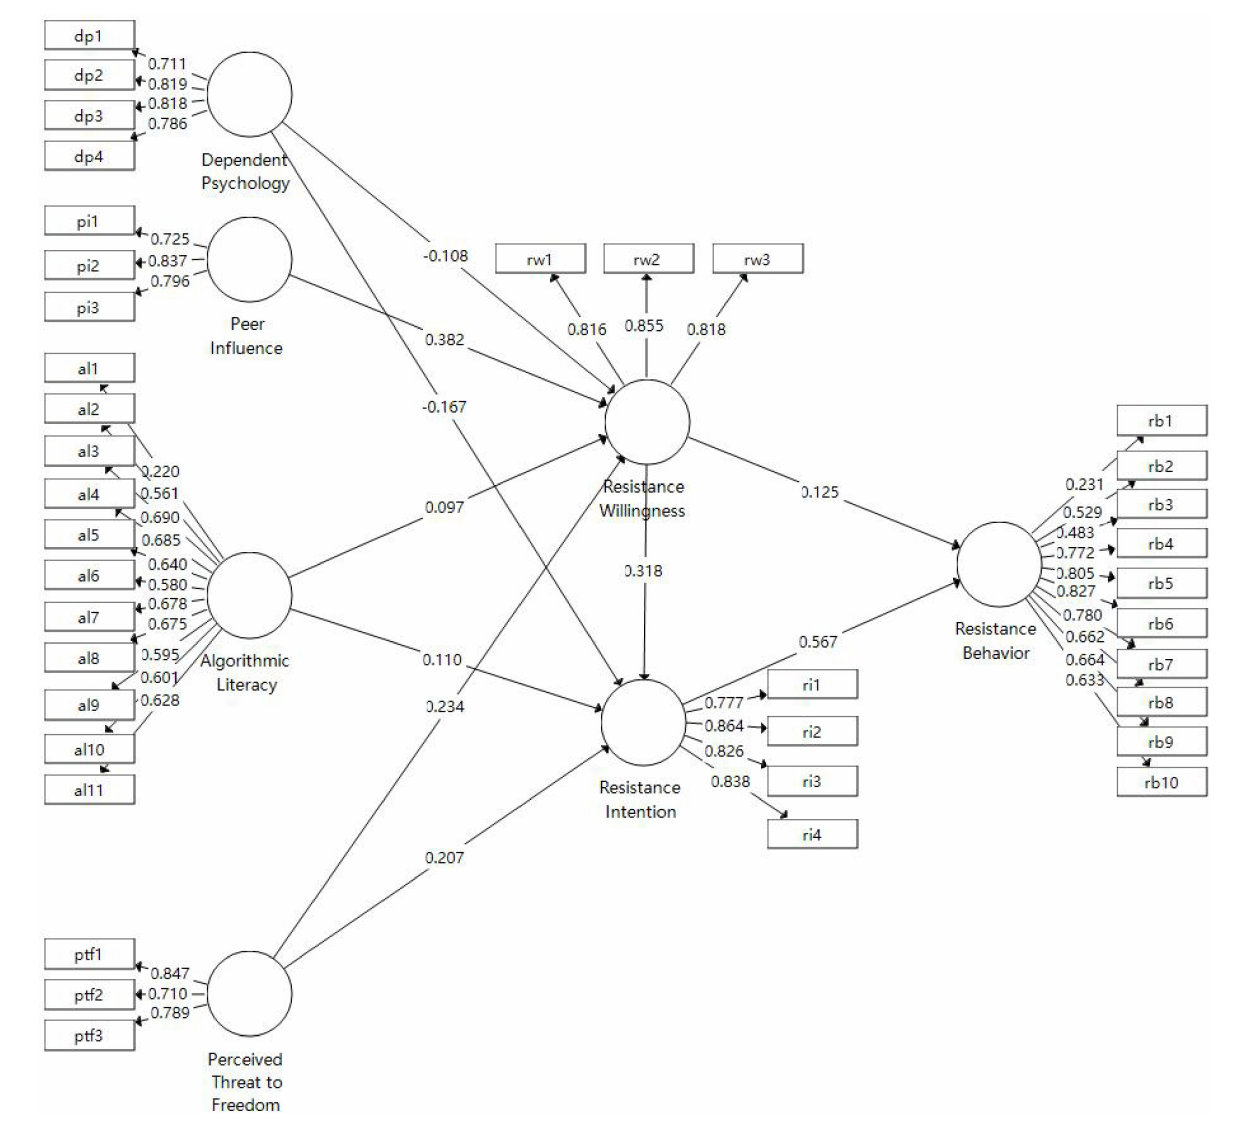
FIGURE 2 | Measurement